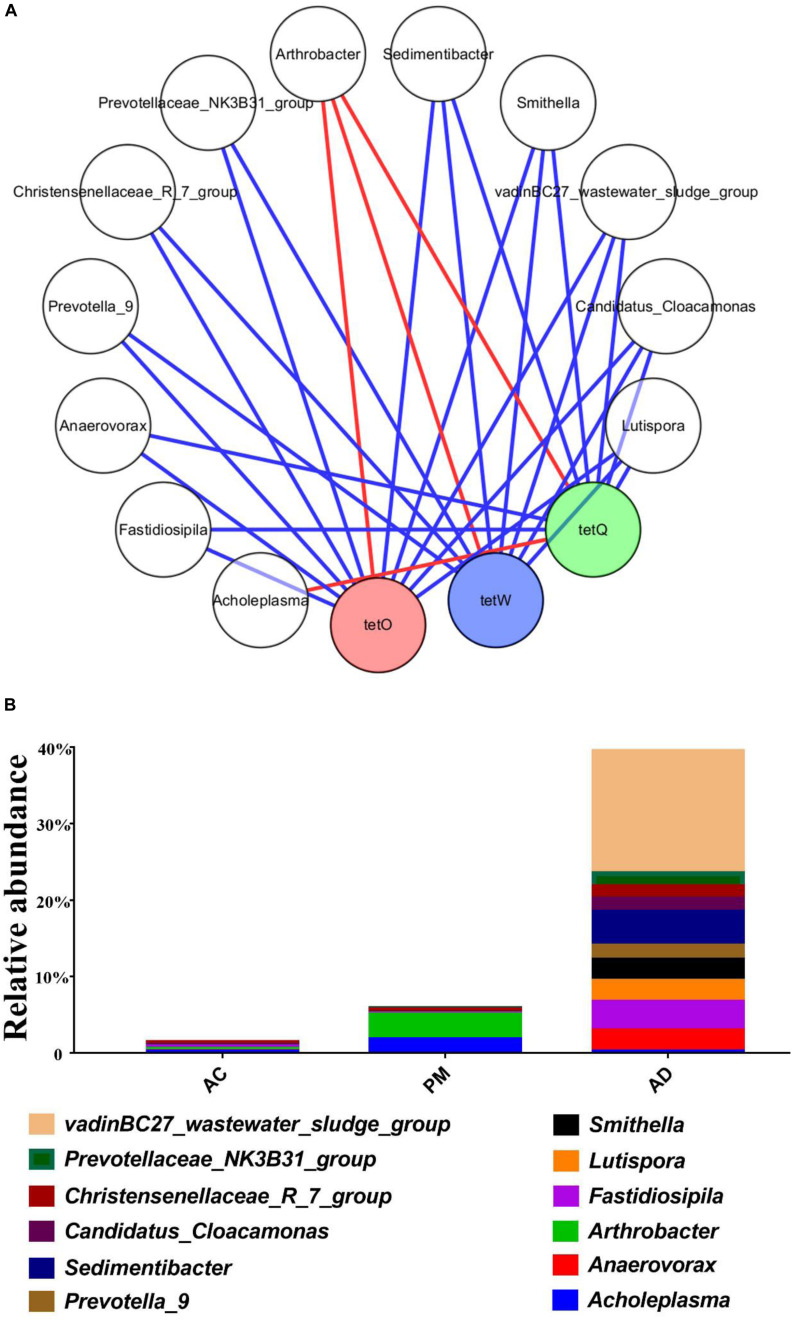
Network analysis of the co-occurrence patterns between ARGs and microbial taxa (A) and abundance of these bacterial genus (B). A connection represents a significant correlation (|R| > 0.6 and p < 0.05; Red: positive, Blue: negative).